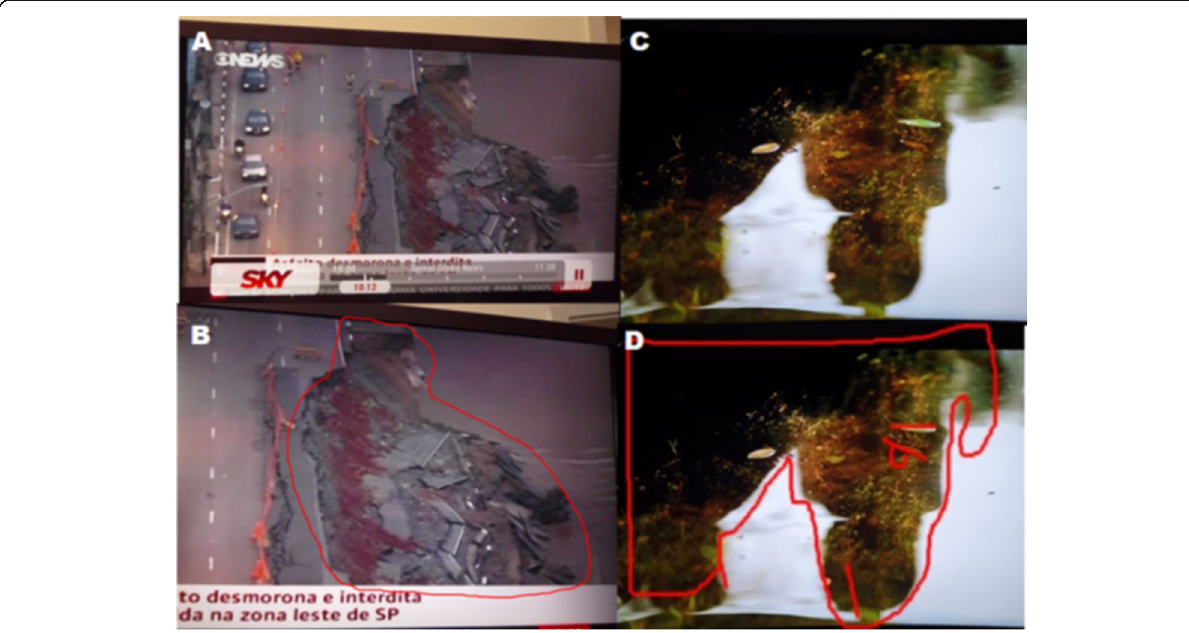
Fig. 1 On the left, the pareidolia of a “ beggar or homeless ” ( B ) is perceived in large size in a highway landslide ( A ); on the right, the reflexion of two people talking ( C ) is an assembled pareidolia-like image of a horse ’ s head ( D